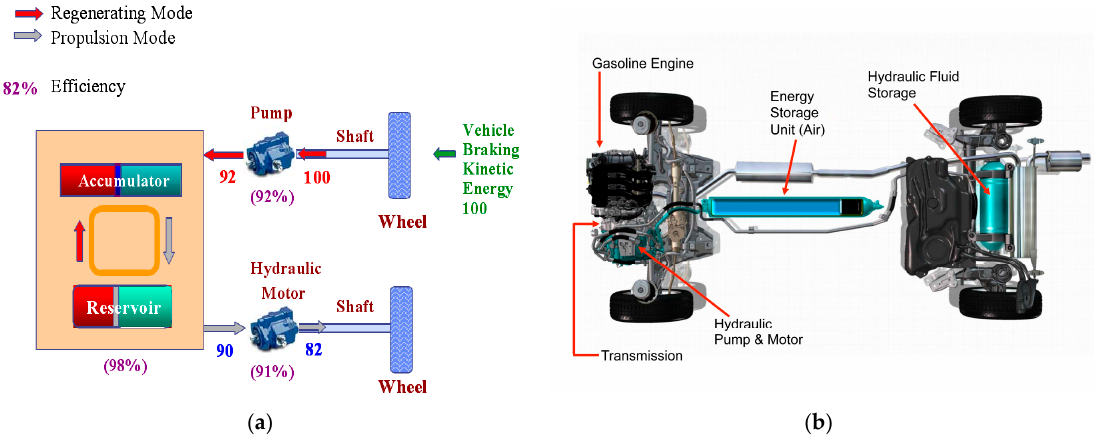
Figure 1. Structure and character of hydraulic hybrid system. ( a ) Energy flow of Eaton Hydraulic hybrid system; ( b ) Structure of PSA ‘Hybrid Air’ system.